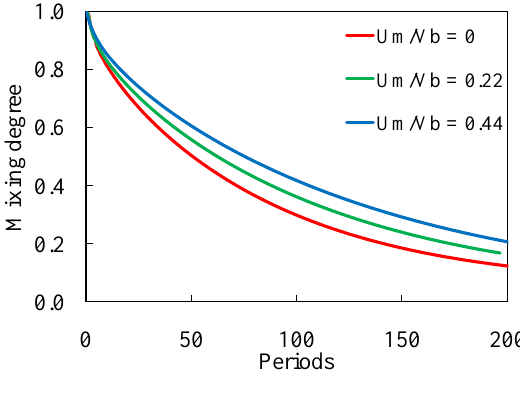
Figure 5. Mixing degree versus time for different flow rates ( of channel flow, V denotes the rotation velocity of b